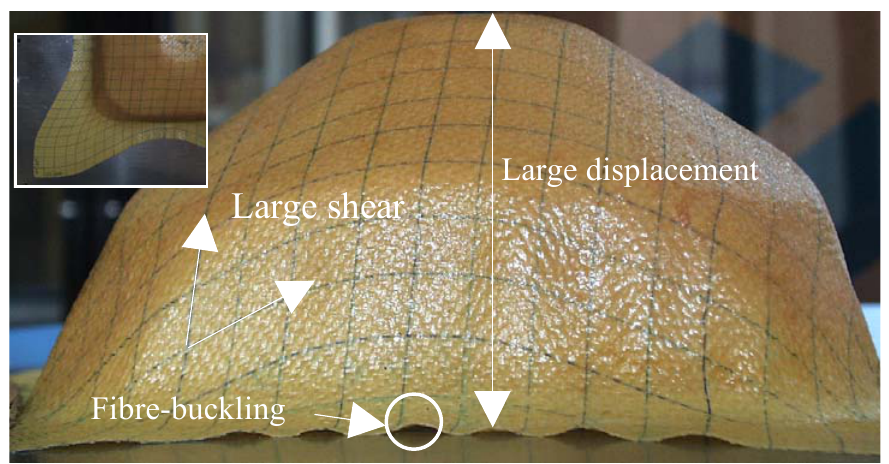
Figure 2. Finite deformations of composite